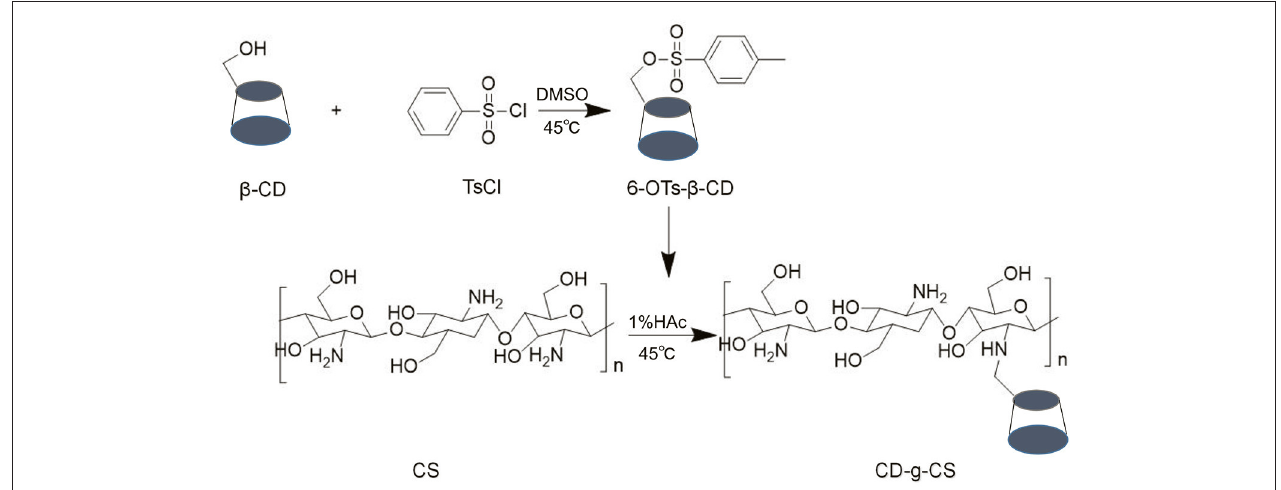
FIGURE 1 | Synthetic pathway of